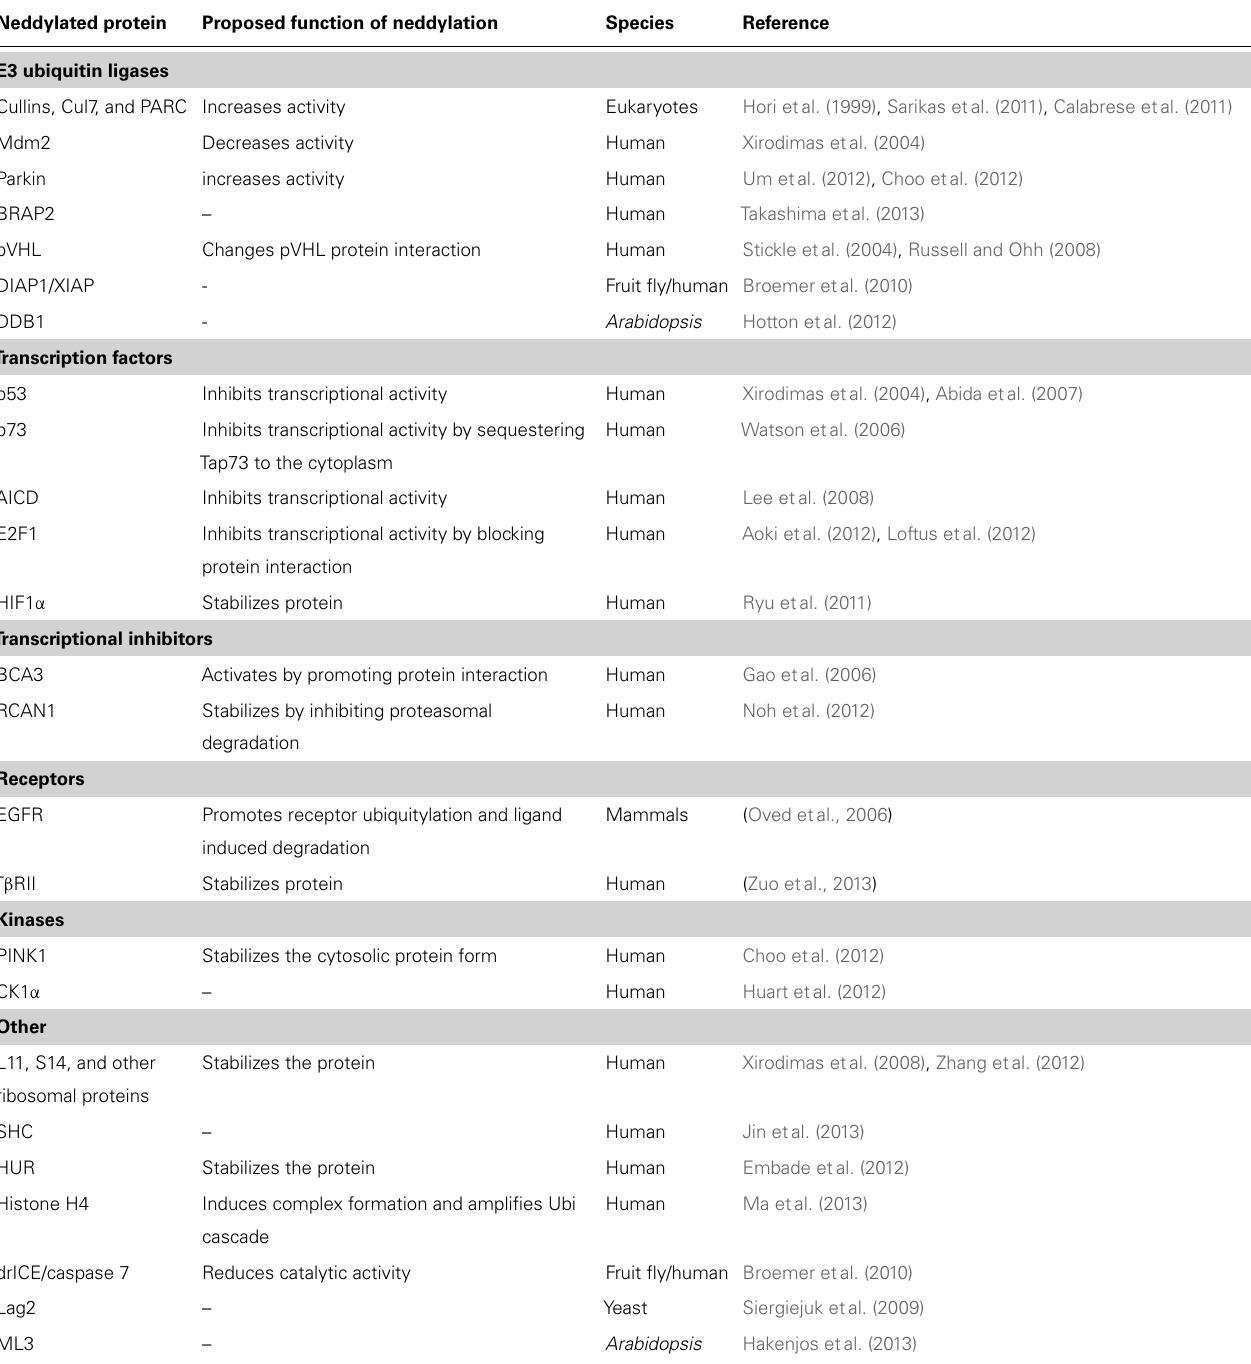
Table 1 | Neddylation substrates. Neddylated